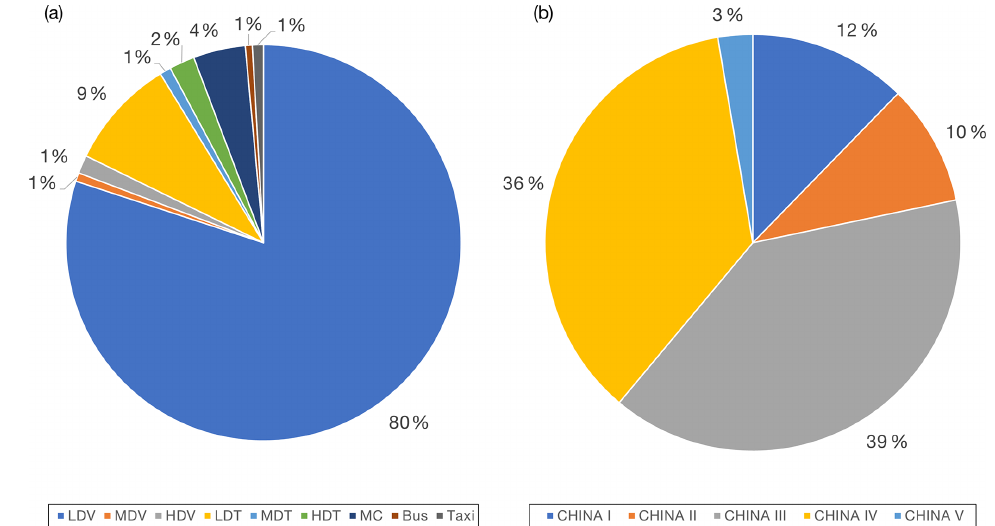
Figure 5. The percentage of (a) vehicle classification and (b) emission